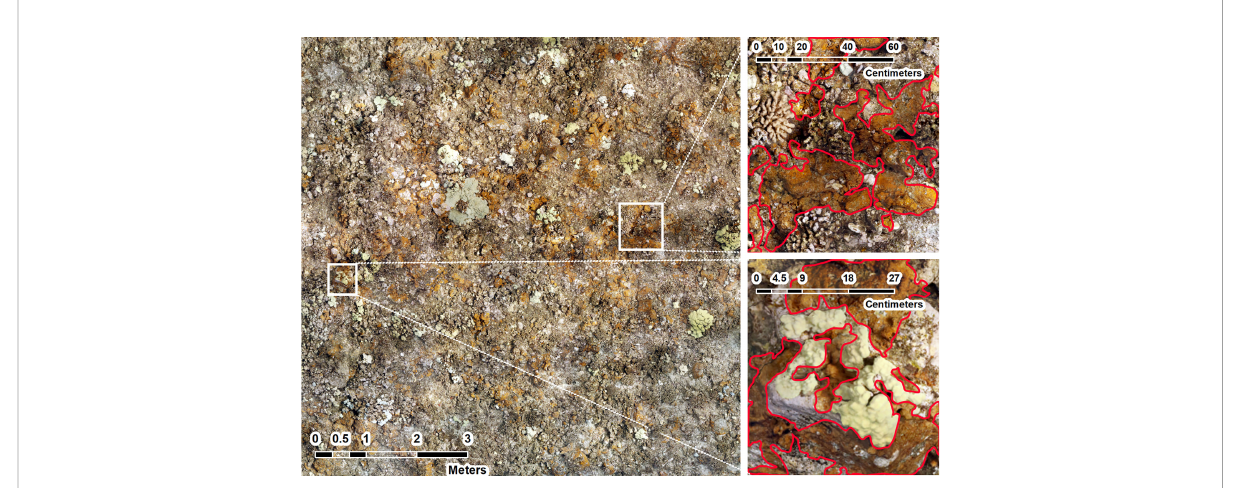
FIGURE 10 Image of 10 m x 10 m orthomosaic in 2020 at SKI site 178 (Left). This site had the highest observed Ramicrusta benthic cover = 37.4% ± 9.17 SE. Ramicrusta is distributed across this SfM mosaic as the rusty-orange encrusting algae throughout the plot (Left) and outlined in red in the images on the right. Ramicrusta can be seen overgrowing a Porites coral in the image on the bottom